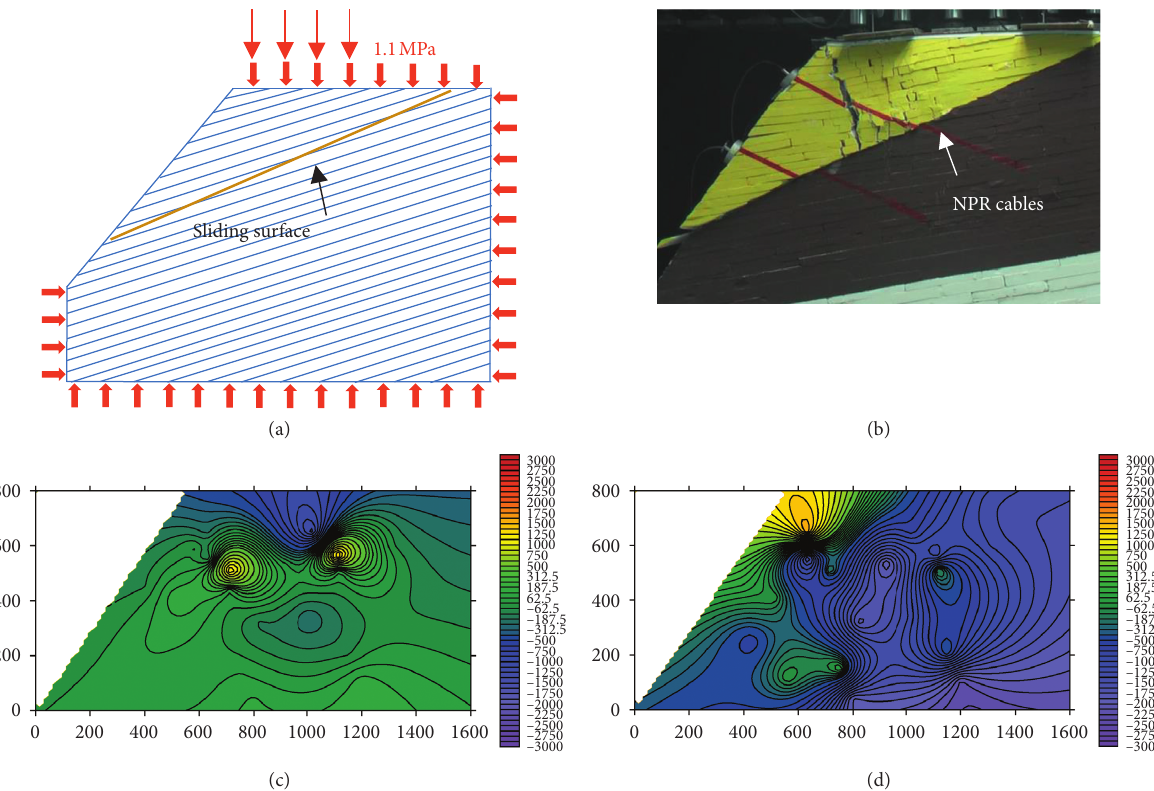
Figure 17: Fourth loading stage stable strain cloud map. (a) Model loading diagram. (b) Model loading variation diagram. (c) X-directional strain cloud map. (d) Y-directional strain cloud map.